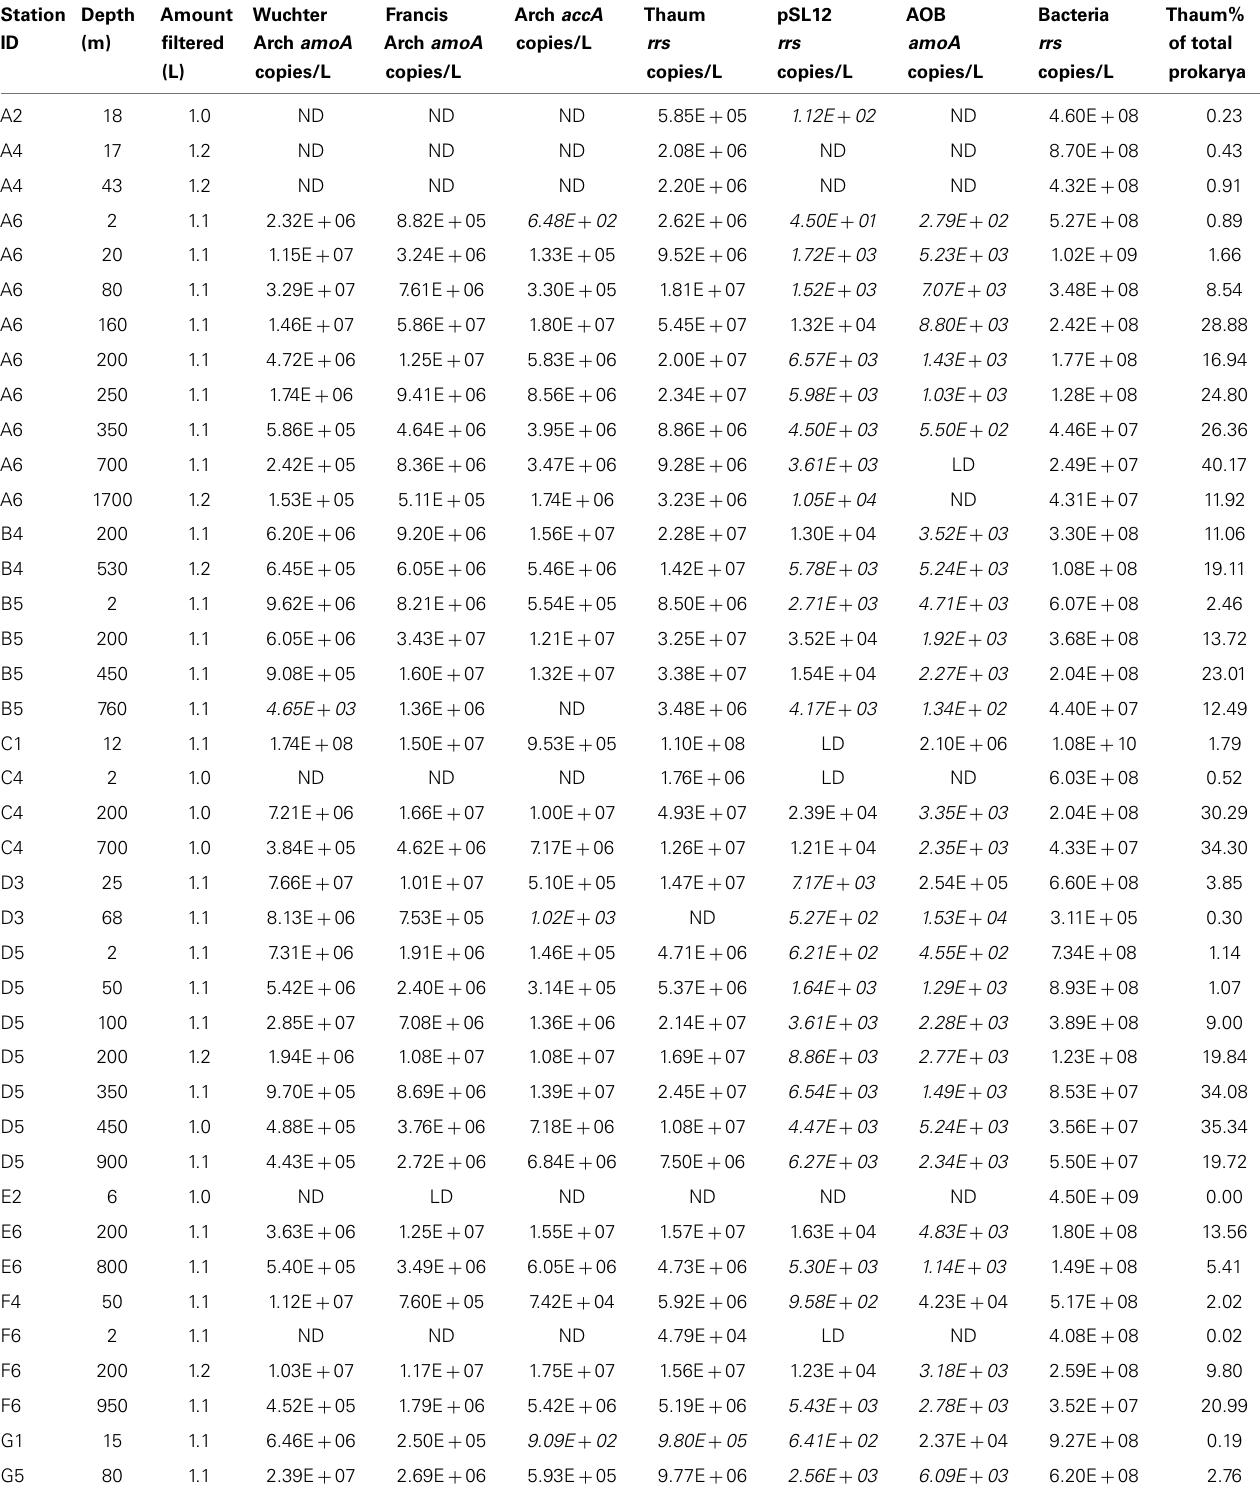
TableA2 | qPCR estimates of the abundance of rrs , amoA , and accA genes in samples from the northern Gulf of Mexico.